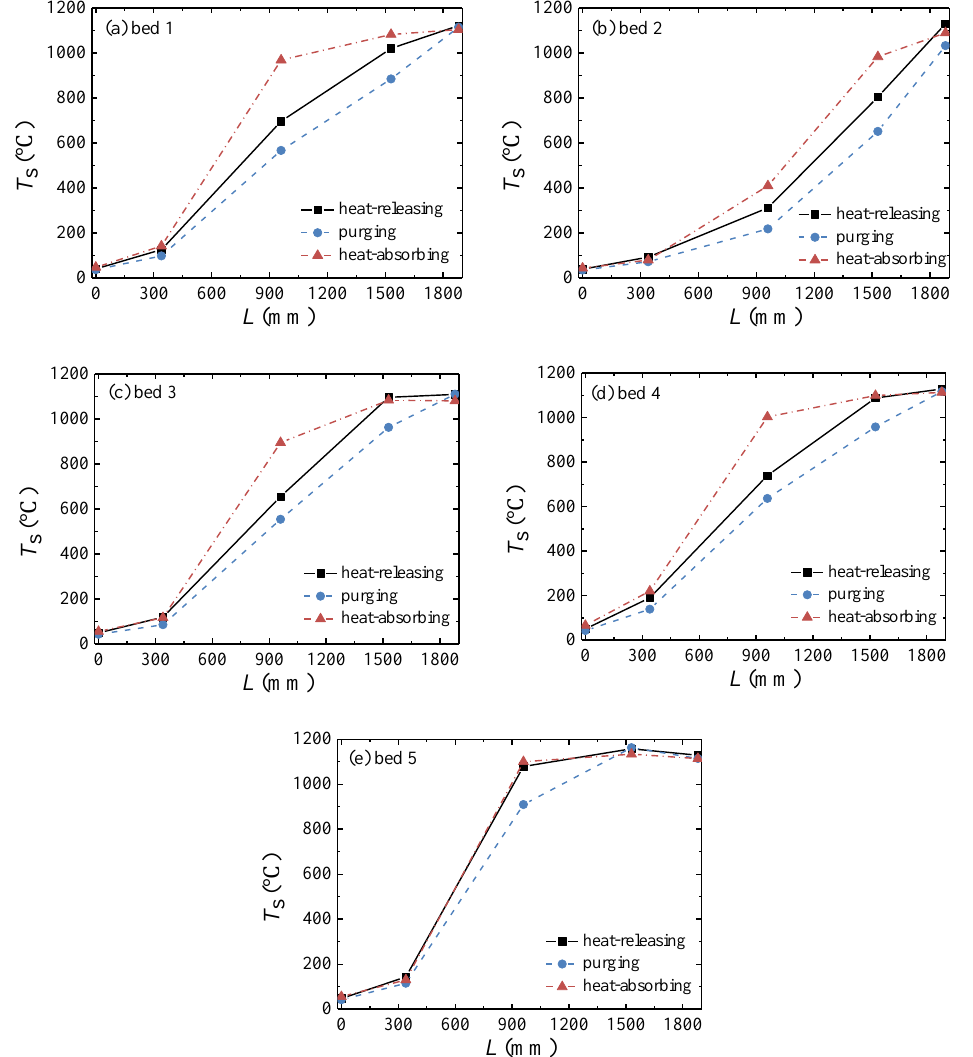
Figure 4. Solid temperature ( T s ) profiles along the length ( L ) of the TFRR at the end of the heat-releasing, purging, and heat-absorbing stages in the five regenerator beds when F in = 105 × 10 3 Nm 3 /h, Y CH4,in = 0.94 vol %, and t c = 450 s.